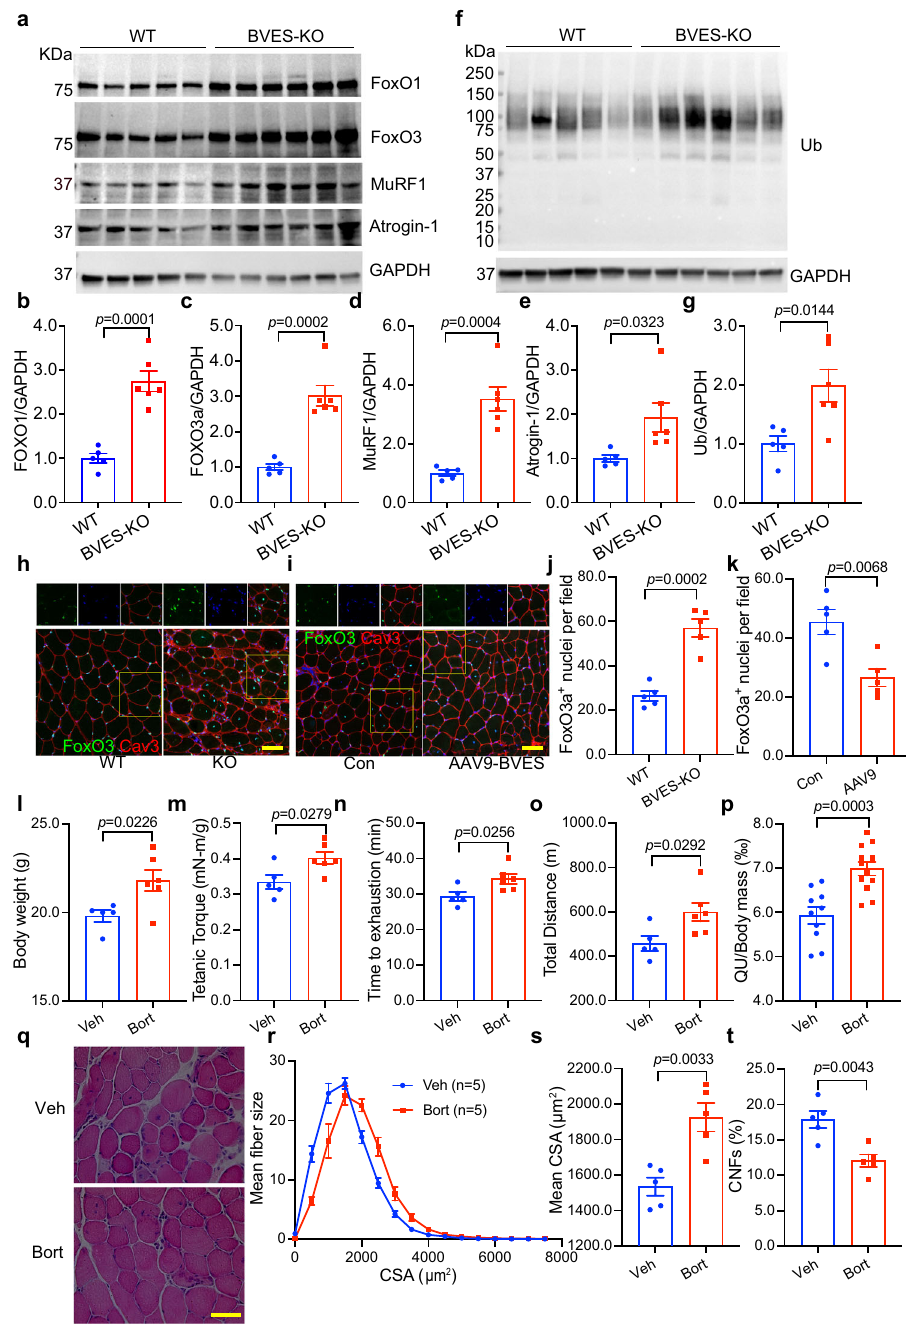
Fig.5|BVESdisruptionenhancestheUPSviaFoxO. Allanimalexperimentswere performed in WT and BVES-KO male mice with the C57BL/6N genetic background. a – e Western blot of FoxO signaling in total GA muscle extracts from 8-month-old WT ( n =5) and BVES-KO ( n =6) male mice ( a ) and quanti fi cation of FoxO1 ( b ), FoxO3a( c ),MuRF1( d )andAtrogin-1( e )normalizedtoGAPDH. f , g Westernblot( f ) and quanti fi cation ( g ) of ubiquitination in total GA muscle extracts from 8-month- old WT ( n =5) and BVES-KO ( n =6) male mice. h Immunostaining of FoxO3a and Cav3(labelingmuscle fi bers)ofGAmusclesfromWTandBVES-KOmale(4months of age; n =5 each). Scale bar: 50 µ m. i Immunostaining of FoxO3a and Cav3 of GA musclesfromAAV9-BVEStreatedandcontralateralcontrolGAmusclesat3months afterinjection ( n =5 per treatment).Scale bar: 50 µ m. j , k Quanti fi cationof FoxO3a positivenucleiper fi eldinWTandBVES-KO( n